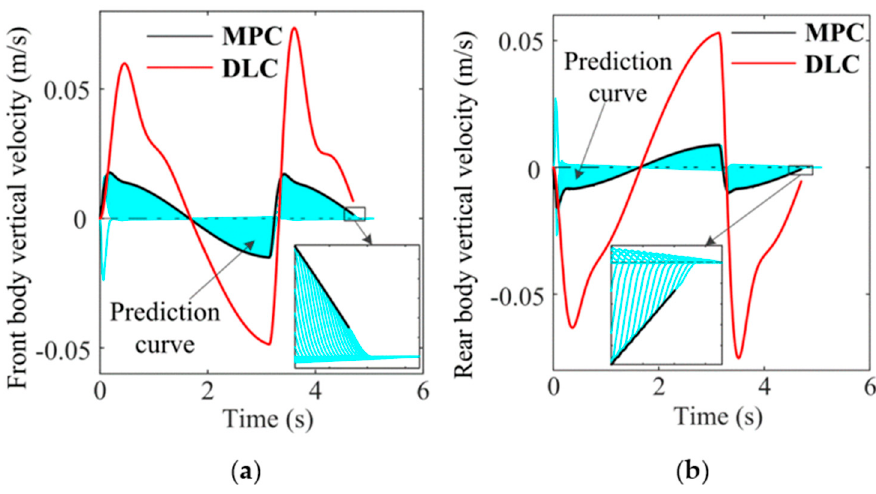
Figure 8. Changes in the vertical velocity of the vehicle body. ( a ) Vertical velocity of the front body; ( b ) Vertical velocity of the rear body.